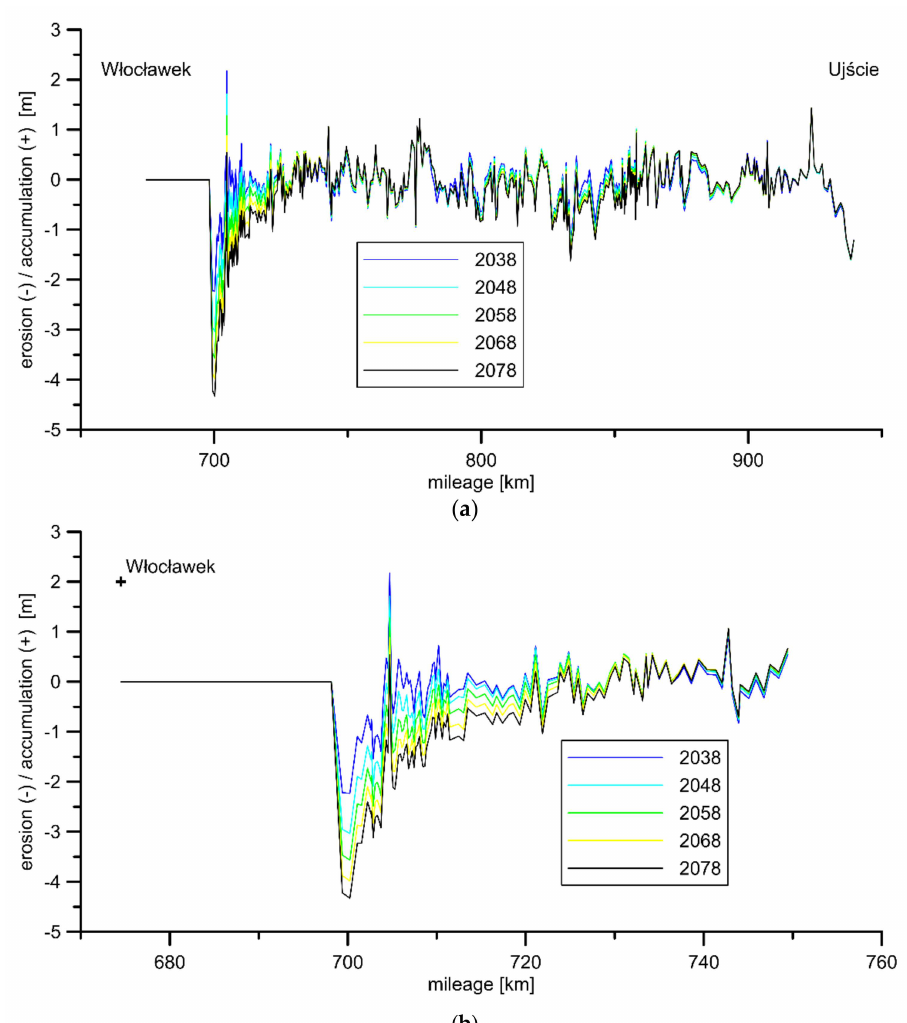
Figure 4. ( a ). Changes in bathymetry over time for the S0 scenario for the entire modeled section in the selected years. ( b ). Changes in bathymetry over time for the S0 scenario below the Włocławek